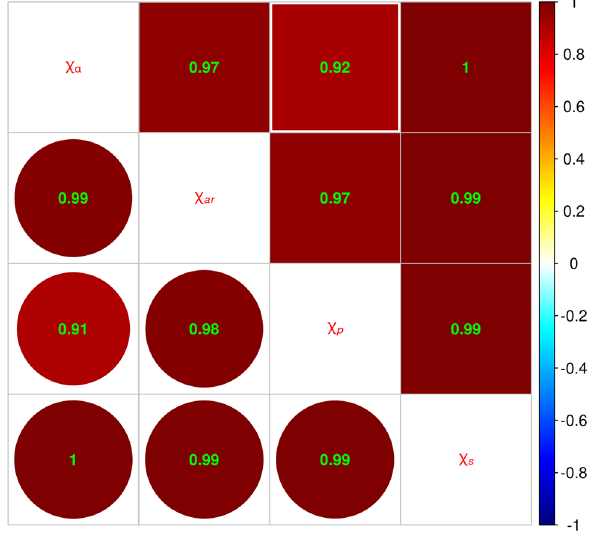
Figure 4: The correlation analysis between electronegativity